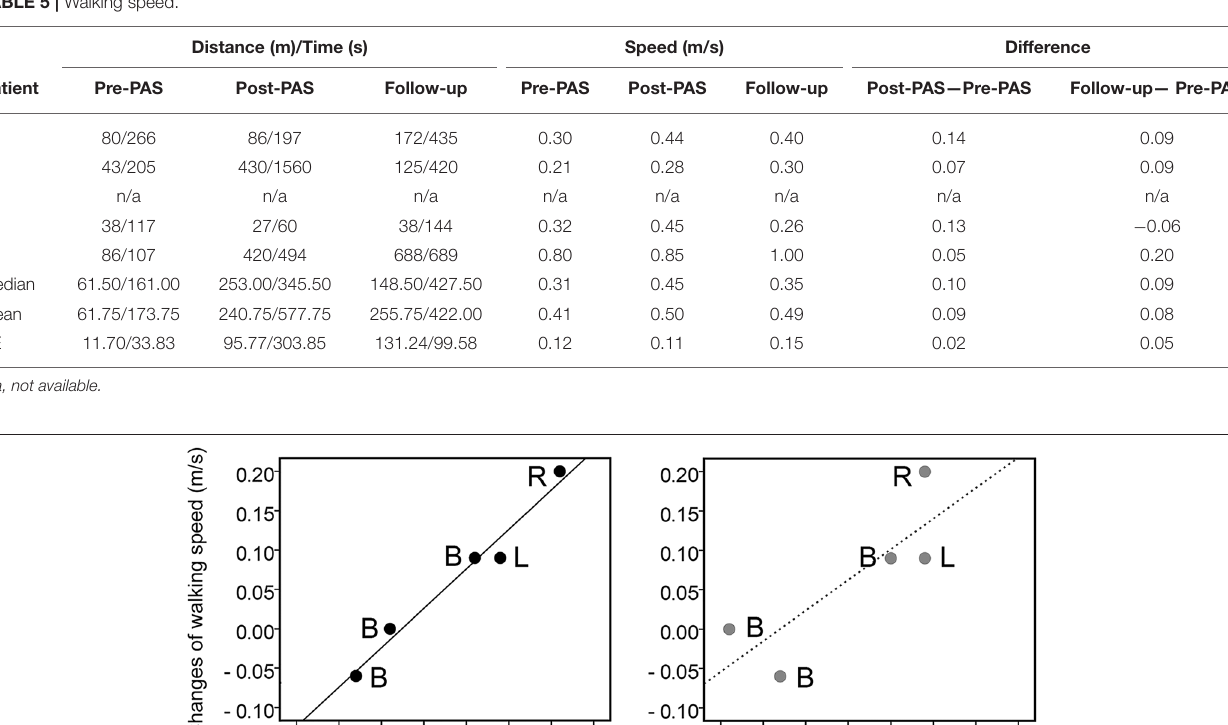
TABLE 5 | Walking speed.